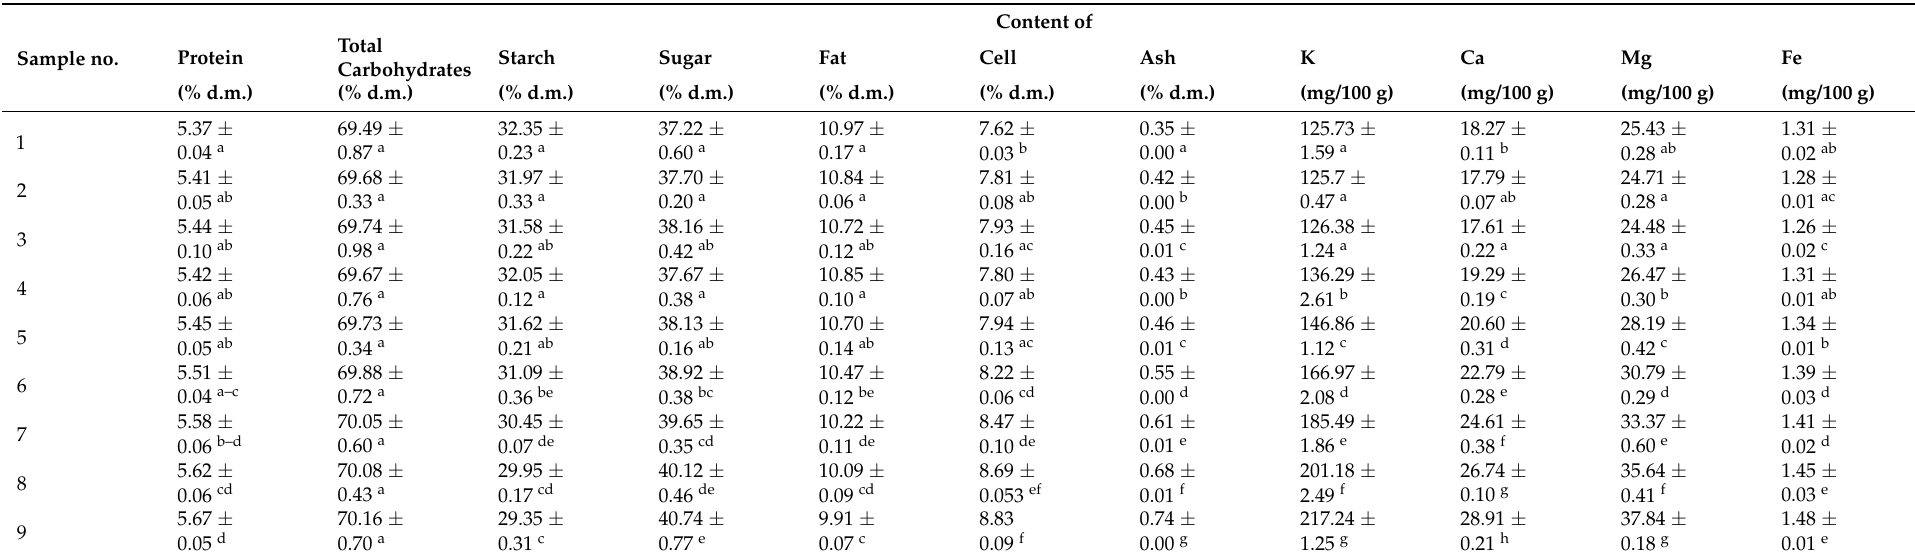
Table 2. Chemical and mineral matter content of cookies with and without addition of L and OL